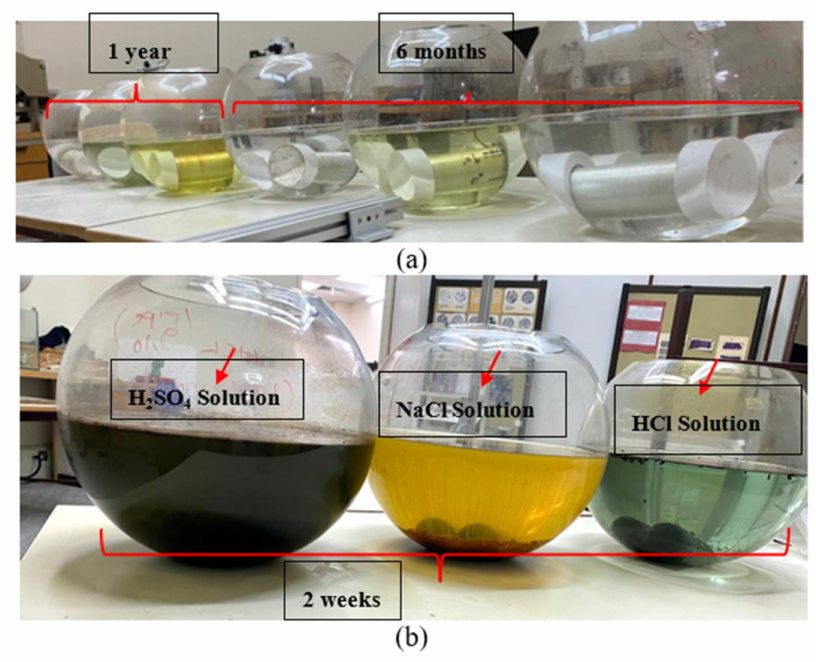
Figure 2. ( a ) GFRP/steel pipes after one year and six months, ( b ) steel pipes after two weeks of immersion in acidic